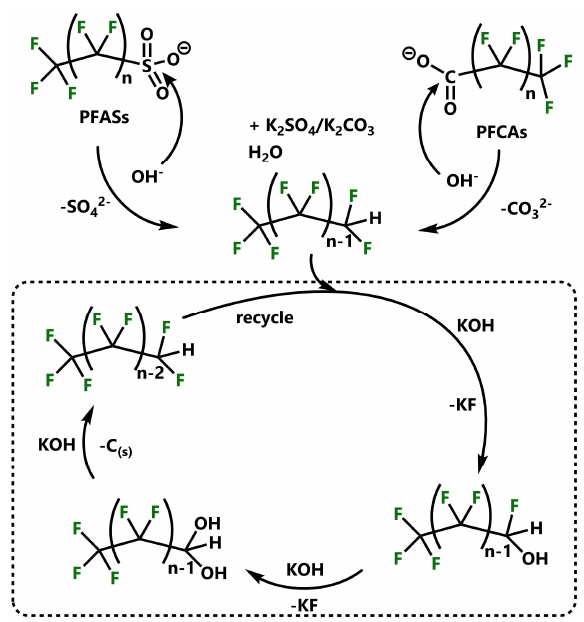
Figure 2. Proposed mechanism of reaction of KOH with PFOS and PFOA under mechanochemical treatment [114].